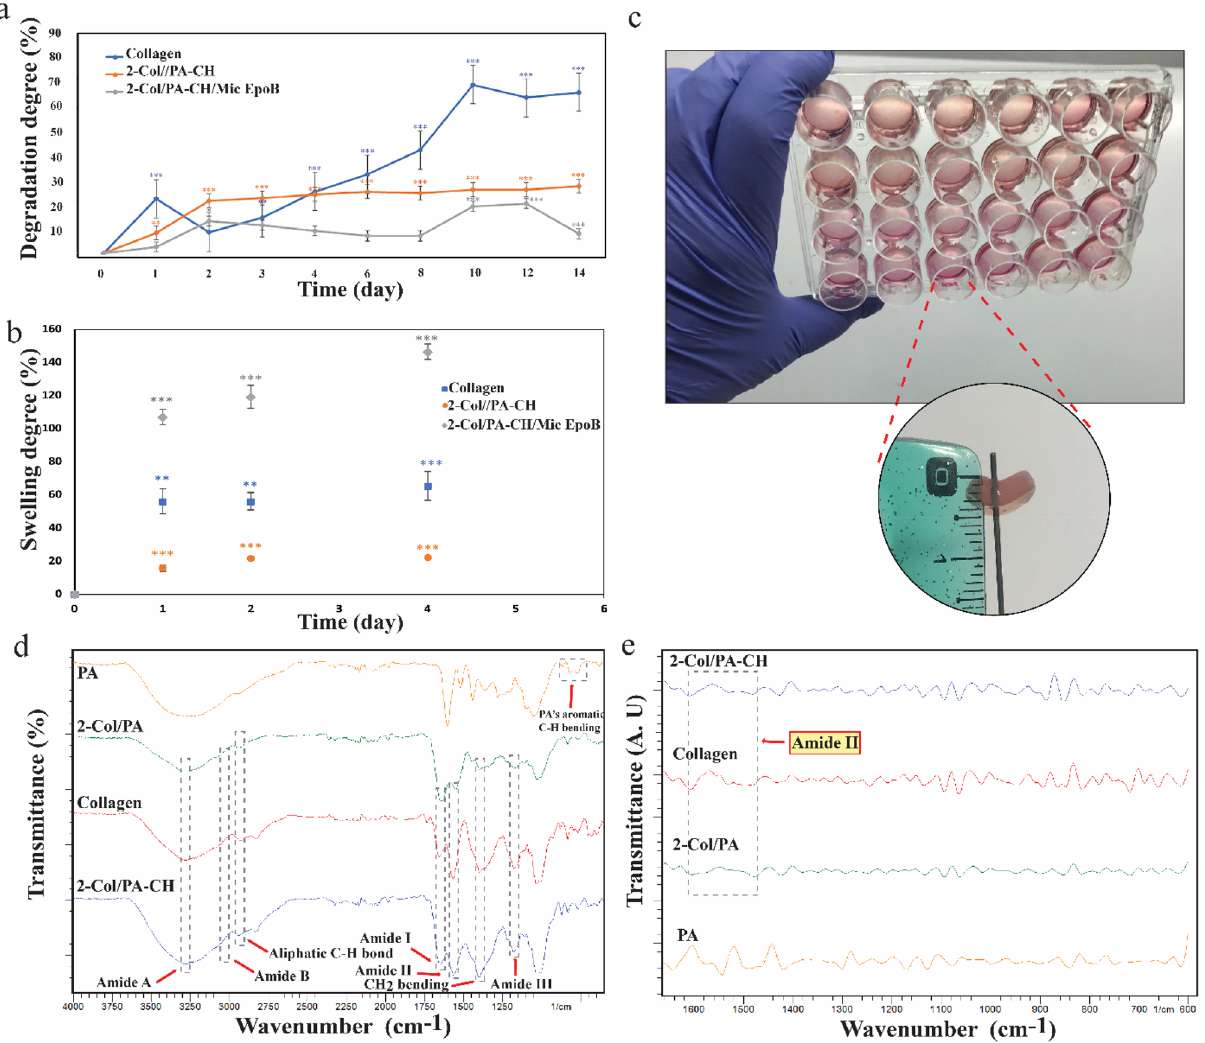
Figure 7. Degradation and swelling degree, and ATR-FTIR spectra of different collagen hydrogel groups. ( a ) Degradation and ( b ) swelling degree of collagen, 2-Col/PA-CH (Cross-linked 2 mg/collagen hydrogel with 0.5% proanthocyanidin and calcium hydroxide), and 2-Col/PA-CH/Mic EpoB (Cross-linked 2 mg/mL collagen hydrogel with 0.5% proanthocyanidin and calcium hydroxide and 2.5 ng/mL Epo B microspheres) hydrogels in DEME-F12 at 37 °C (The time duration: 14 days for degradation test and 4 days for swelling test). *P < 0.05, **P < 0.01, ***P < 0.001. ( c ) The consistency in cross-linked collagen hydrogels. ( d ) The ATR-FTIR spectra of PA, collagen, 2-Col/PA, 2-Col/PA-CH and, ( e ) their second-derivative spectra in the amide B region. The main peaks are shown by red arrows and gray dash lines. The second-derivative spectra in the amide B region indicate secondary structure conformational changes in the two cross-linked hydrogels scaffold (2-Col/PA and 2-Col/ PA-CH) compared to the collagen (uncross-linked) hydrogel